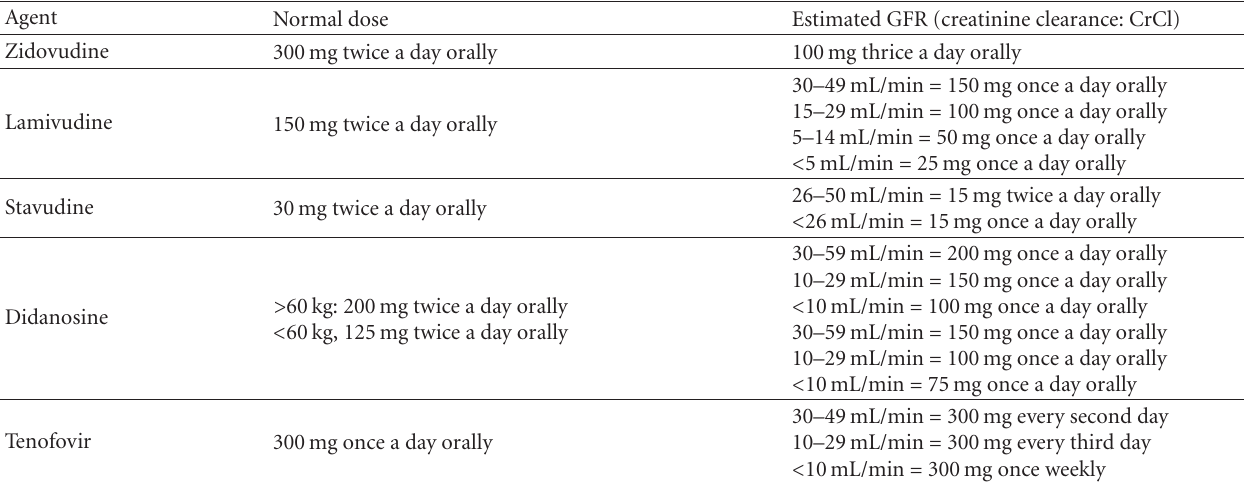
Table 3: Dose adjustment for commonly used